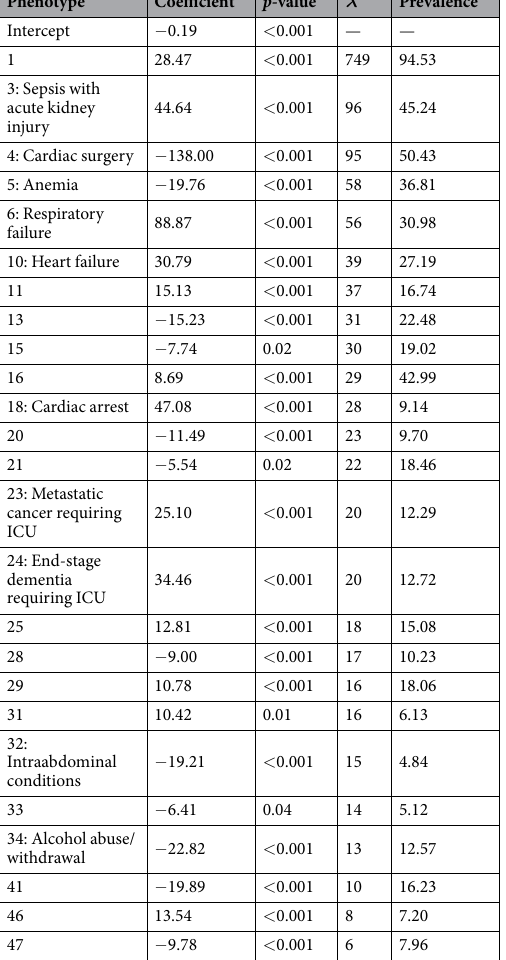
Table 3. Logistic regression coefficient from feature selection, p -value, and prevalence. Ten representative phenotypes are 3: Sepsis with acute kidney injury, 4: Cardiac surgery, 5: Anemia, 6: Respiratory failure, 10: Heart failure, 18: Cardiac arrest, 23: Metastatic cancer requiring ICU, 24: End-stage dementia requiring ICU for comport care, 32: Intraabdominal conditions, 34: Alcohol abuse/withdrawal. λ r = || A : r || F || B : r || F || C : r || F (for frequency). Prevalence = (the number of patients whose membership to the phenotype is non-zero/the total number of patients) ×